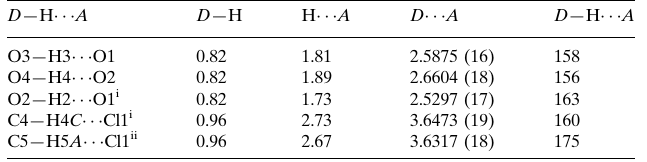
Hydrogen-bond geometry (A˚ , (cid:2)